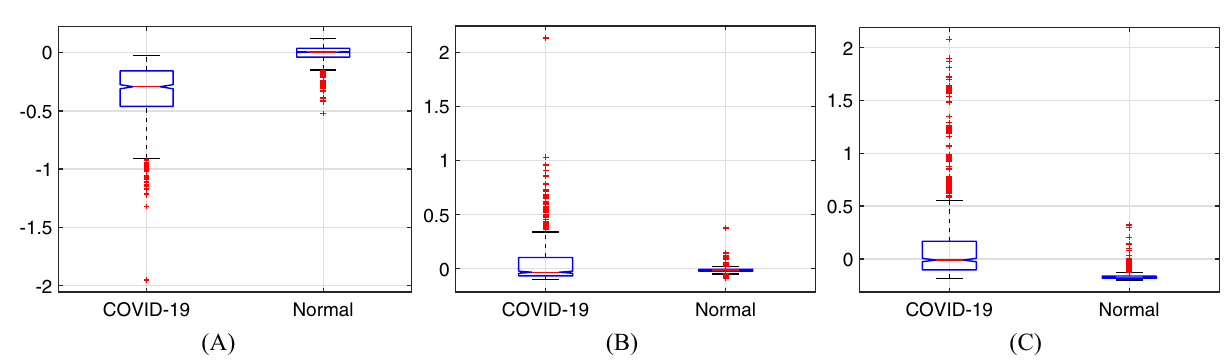
Figure 6. Box-plots among training feature samples in the previous three dimensions by one-way ANOVA. ( A ) The 1st dimension. ( B ) The 2nd dimension. ( C ) The 3rd